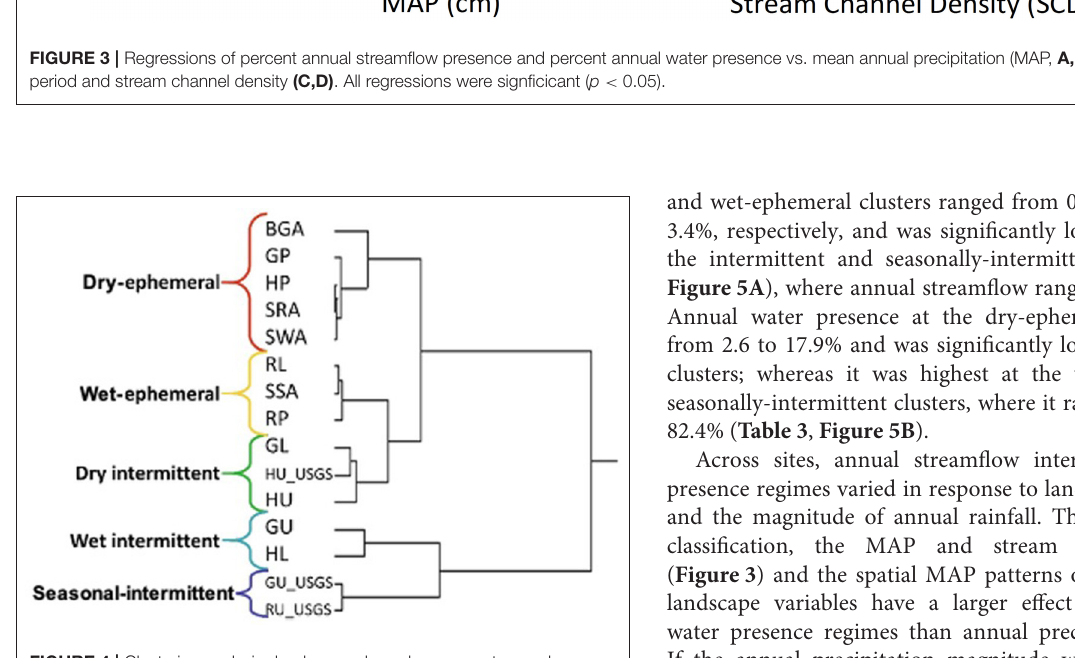
FIGURE 4 | Clustering analysis dendrogram based on percent annual streamflow presence (ASFP) and percent annual water presence (AWP). We identified 5 statistically distinct streamflow